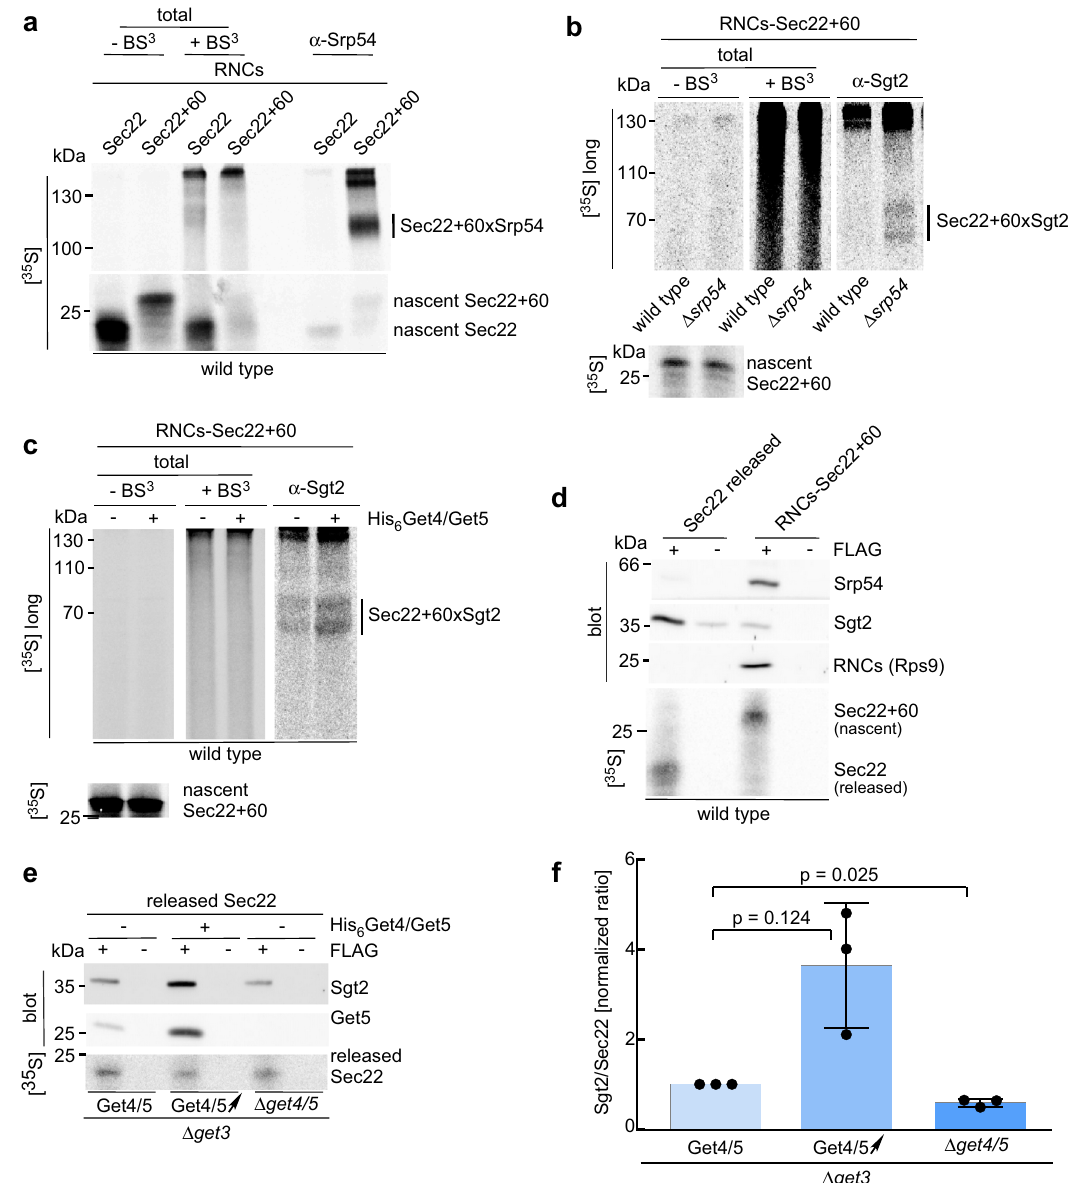
Fig. 5 Ribosome-bound Sgt2 is in contact with a nascent TA sequence. a SRP contacts the TA sequence of nascent Sec22 + 60 exposed outside of the ribosomal tunnel. RNCs carrying radiolabeled nascent Sec22 or Sec22 + 60 were crosslinked with BS 3 and SRP was af fi nity puri fi ed with α -Srp54. Total (5%) translation reactions before ( − BS 3 ) or after ( + BS 3 ) crosslinking. See Supplementary Fig. 5a and Methods. Shown is an autoradiograph; Sec22 + 60xSrp54 represents the crosslink product between Srp54 and nascent Sec22 + 60. b Sgt2 contacts nascent Sec22 + 60 when SRP is absent from the reaction. Radiolabeled RNCs-Sec22 + 60 generated in wild type or Δ srp54 translation extracts were analyzed as detailed in a using α -Sgt2 for af fi